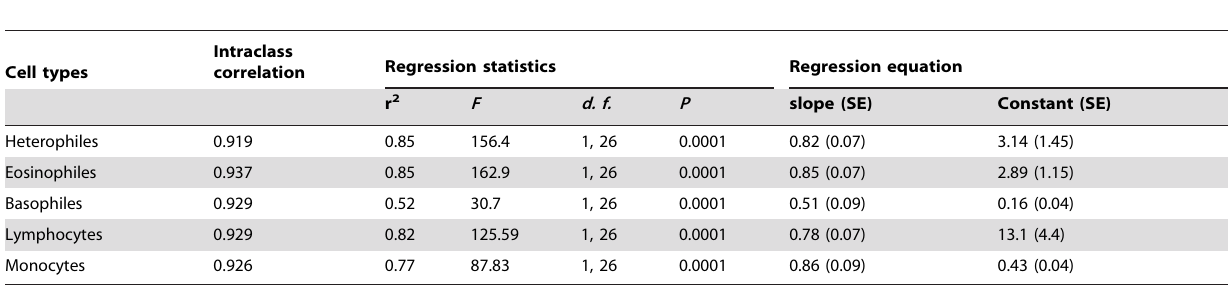
Table 2. Correlations when counting 250, 150 and 100 cells in blood smears for defining the differential counts in blood of 14 days-old nestlings spotless starling.